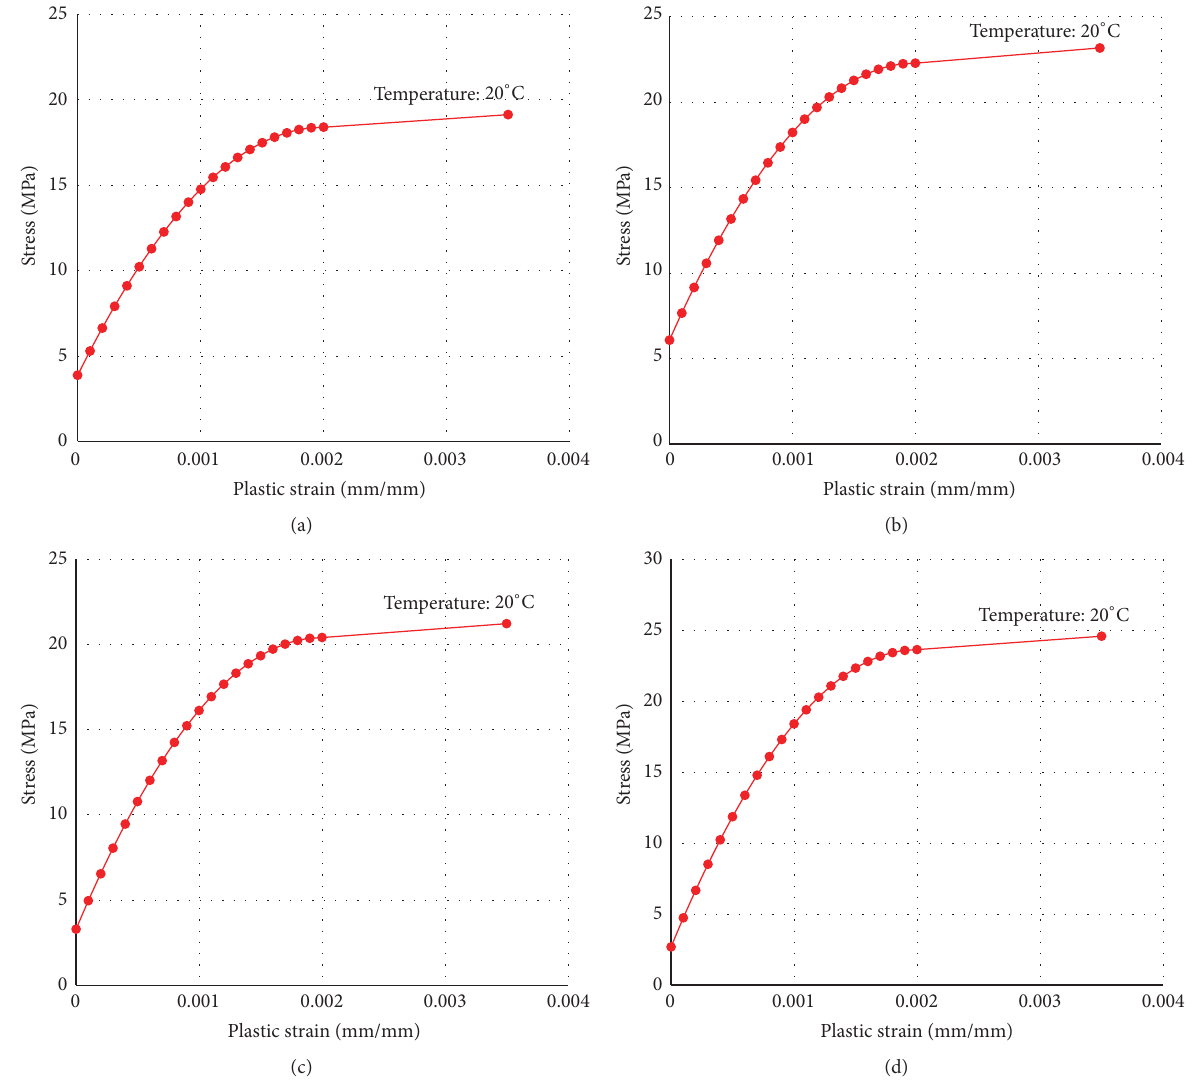
Figure 7: Multilinear isotropic hardening material laws introduced in the models: (a) LWC LSDur-23, (b) LWC LSDur-28, (c) LWC LSDur- 37, and (d) normal concrete